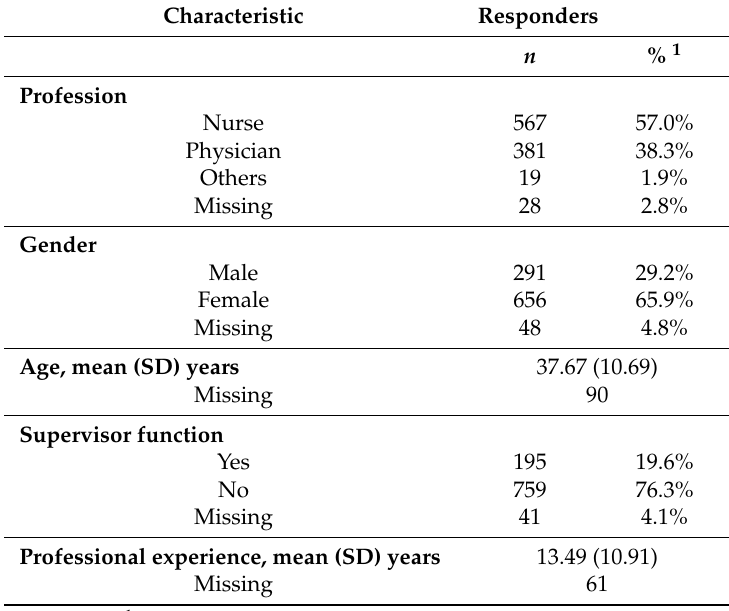
Table 3. Demographic characteristics of study